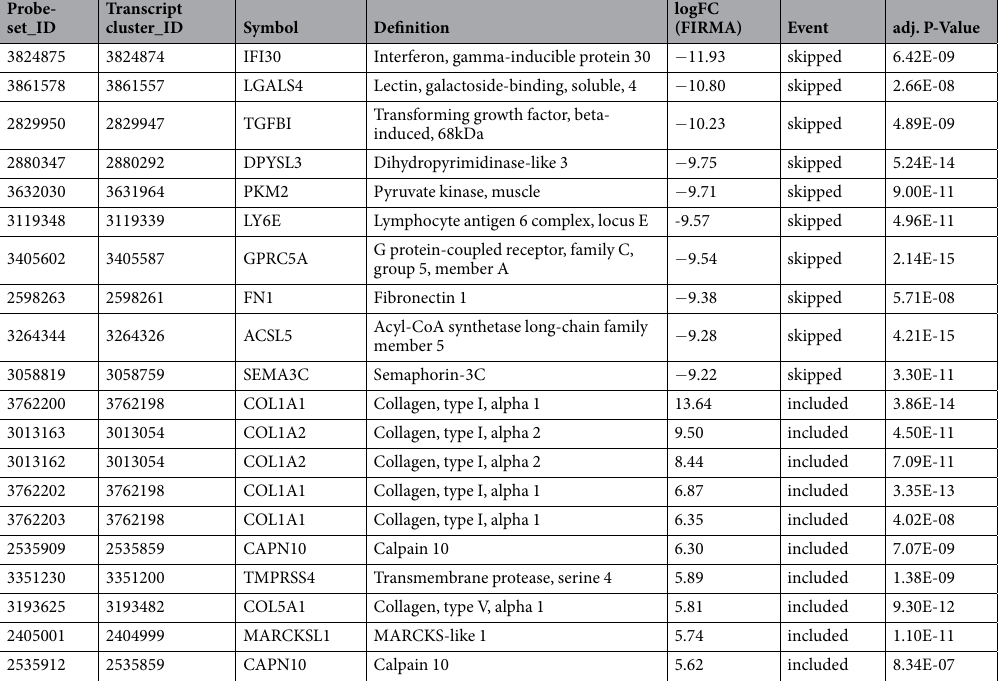
Table 3. Top differentially spliced protein-coding genes between PDAC and normal pancreas.